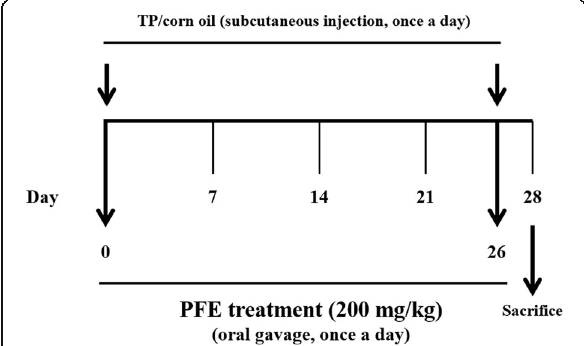
Fig. 1 Flow diagram of the experimental procedure: a rat model of benign prostatic hyperplasia. PFE, Ponciri fructus extract; TP, testosterone